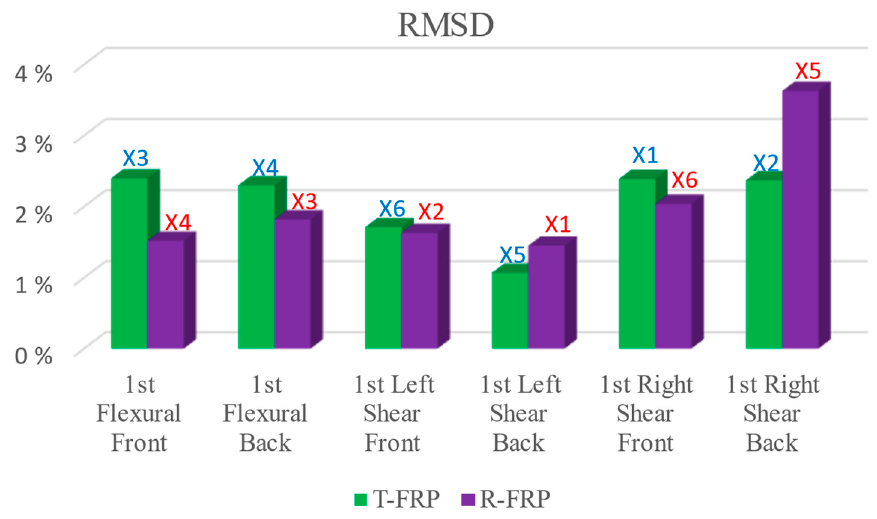
Figure 23. RMSD index values of externally bonded PTZs of T-FRP and R-FRP.